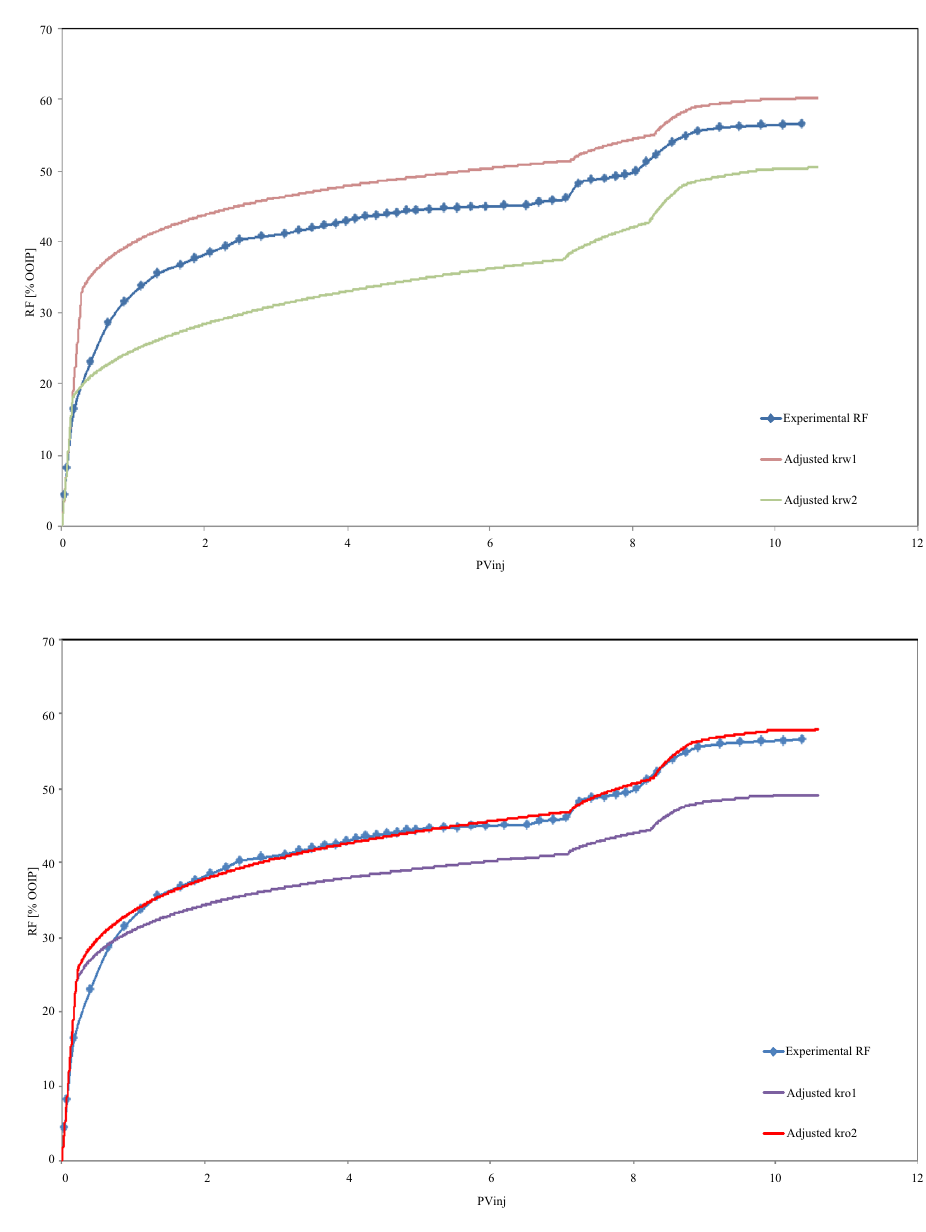
Fig. 4 Effect of tuning water relative permeability curve on cumulative RF